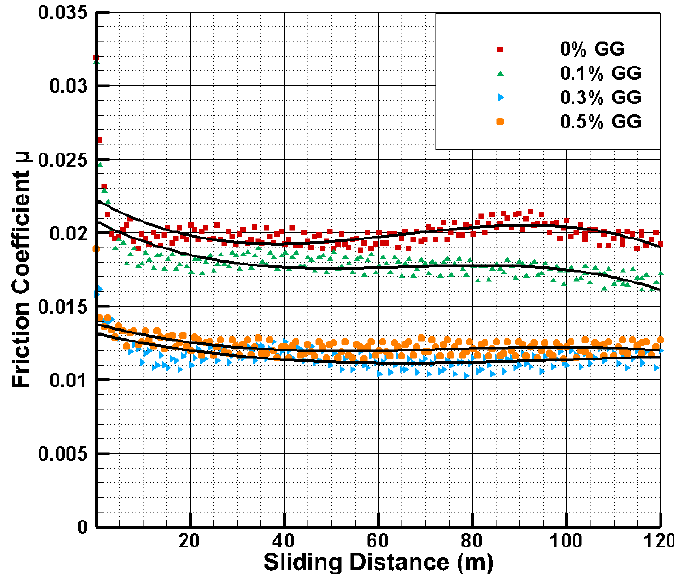
Figure 4. Friction coefficient versus sliding distance for PVA/GG hydrogels of different GG content under the load of 10 N and the sliding velocity of 0.2 m/s. The solid lines are guides to the eye.